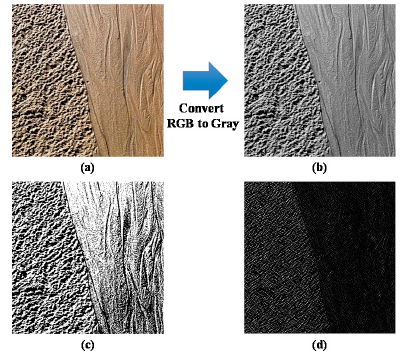
Figure 3. Converting RGB to gray value ( a ) target image, and ( b ) gray scale image; and tactile images, ( c ) binary image, and ( d ) edge detected image.